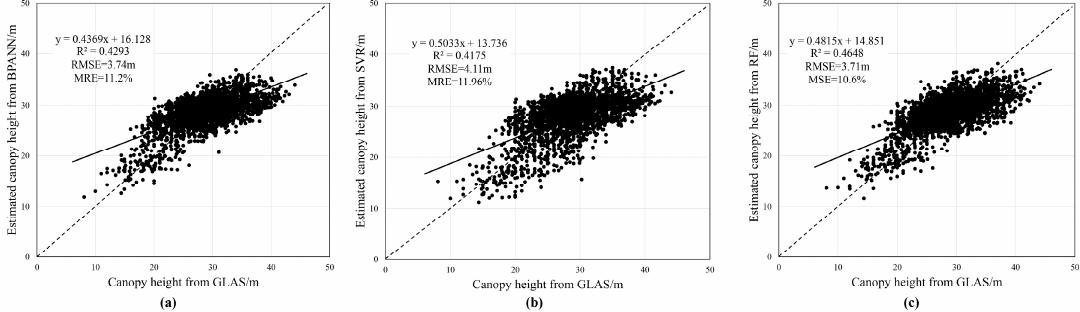
Figure 5. The evaluation results of the machine learning models. ( a ) Evaluation result of the BPANN model; ( b ) evaluation result of the SVR model; and, ( c ) evaluation result of the RF power model.